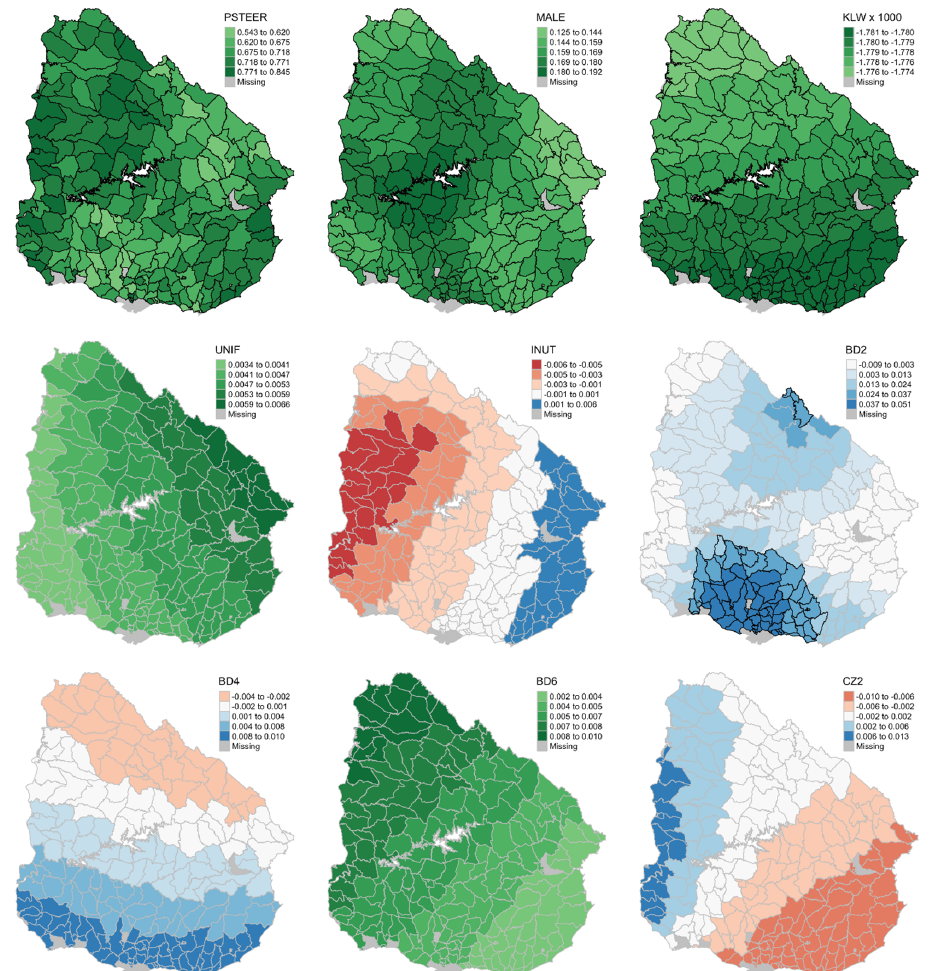
Figure 2. SVCs for market and cattle characteristics: PSTEER (steer price), MALE (male), KLW (live weight), UNIF (shape uniformity), INUT (improved nutrition), BD2 (Angus breed), BD4 (Continental breed), BD6 (Zebu breed), and CZ2 (British Continental cross). The SVCs are shown with their significance from zero by highlighting the border of their areal unit (otherwise not significant at 5% level) and have all been corrected for multiple comparisons.